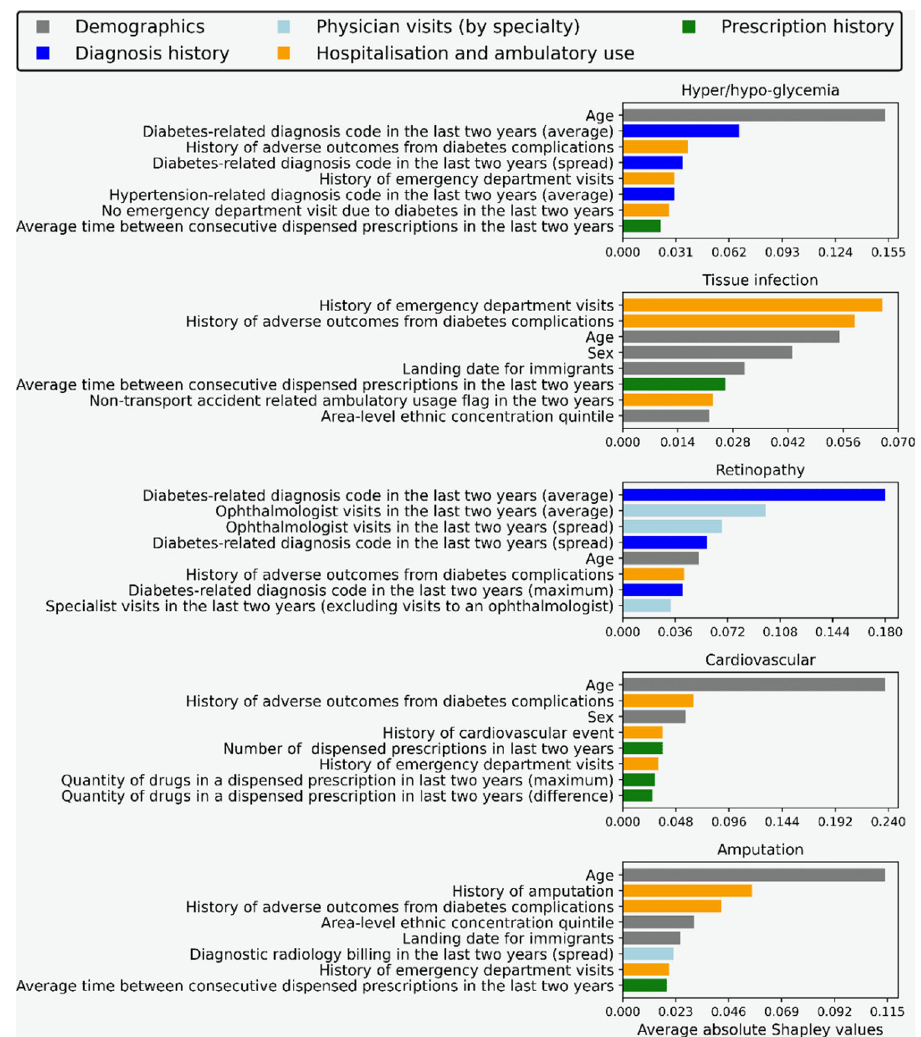
Fig. 3 Top eight features for each complication. For each feature we show the corresponding administrative health dataset where it is derived from, and the magnitude of the contribution to the model. The contribution is measured using the mean absolute Shapley values (see Methods) over a large random sample of 10,000 test instances. The feature contributions here do not represent causal effects, and only indicate correlation with the target predicted adverse outcomes as captured by the